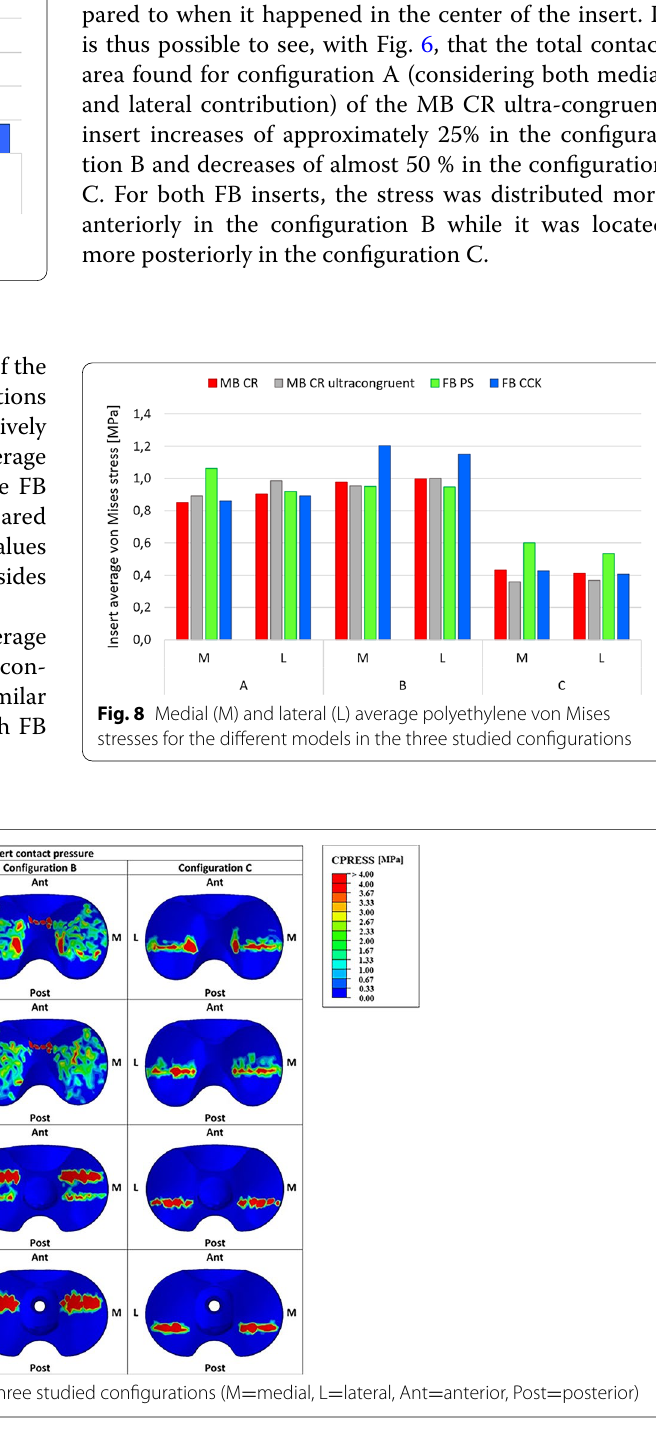
medial, L lateral, Ant anterior, Post posterior) = = = =